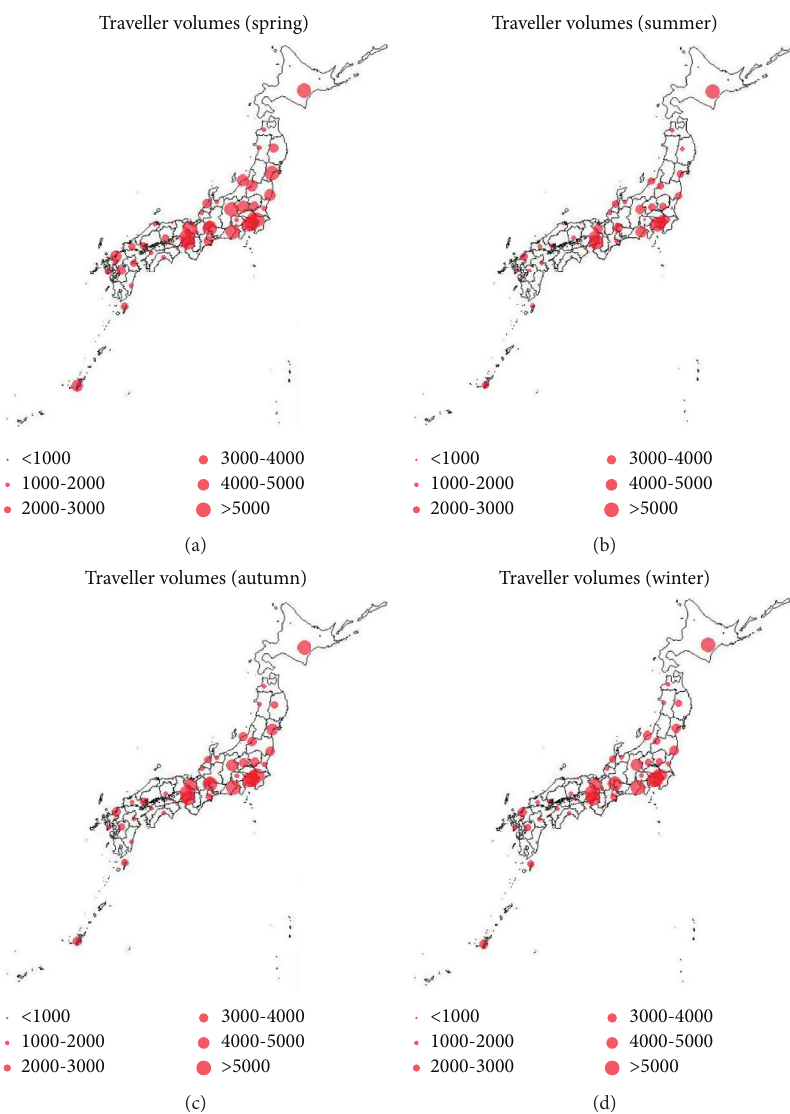
Figure 2: Seasonal mapping of traveler volumes. Red points represent the monthly traveler volumes of each